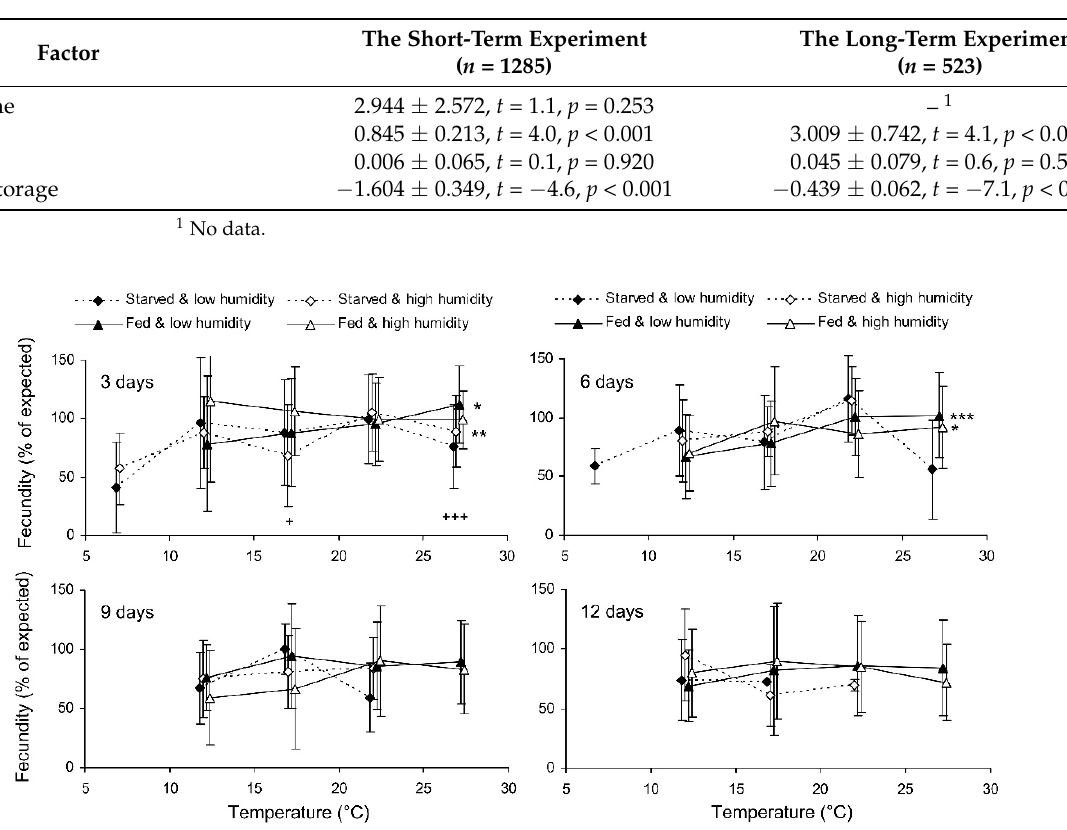
Figure 4. Fecundity of Cheilomenes propinqua females in relation to the temperature, humidity, trophic regime, and duration of storage (the results of the short-term experiment). The means and SD of the percentage of the expected fecundity calculated based on the female size are shown. The duration of storage is indicated in the graphs. Asterisks at the right end of the line indicate a significant influence of temperature—*— p < 0.05, **— p < 0.01, ***— p < 0.001—according to a one-way ANOVA test. Plus symbols indicate the significant influence of the trophic regime at the corresponding temperature, +— p < 0.05, +++— p < 0.001, according to a two-way ANOVA test (humidity was the second factor).